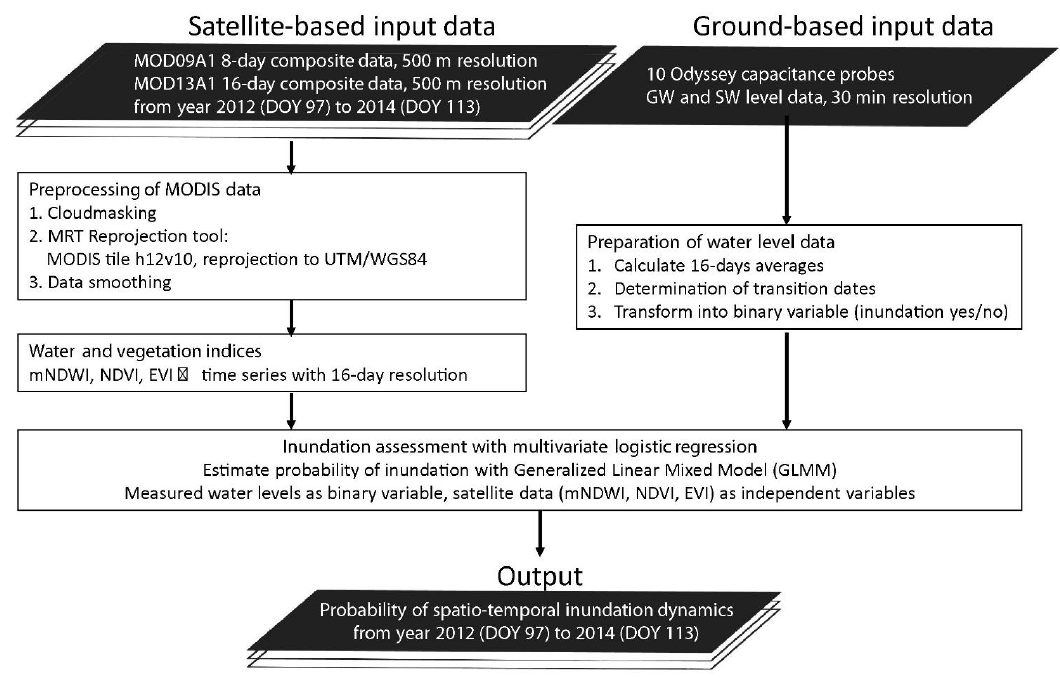
Figure 2. Flow chart of satellite- and ground-based inundation assessment for the study period (1 April 2012–30 March